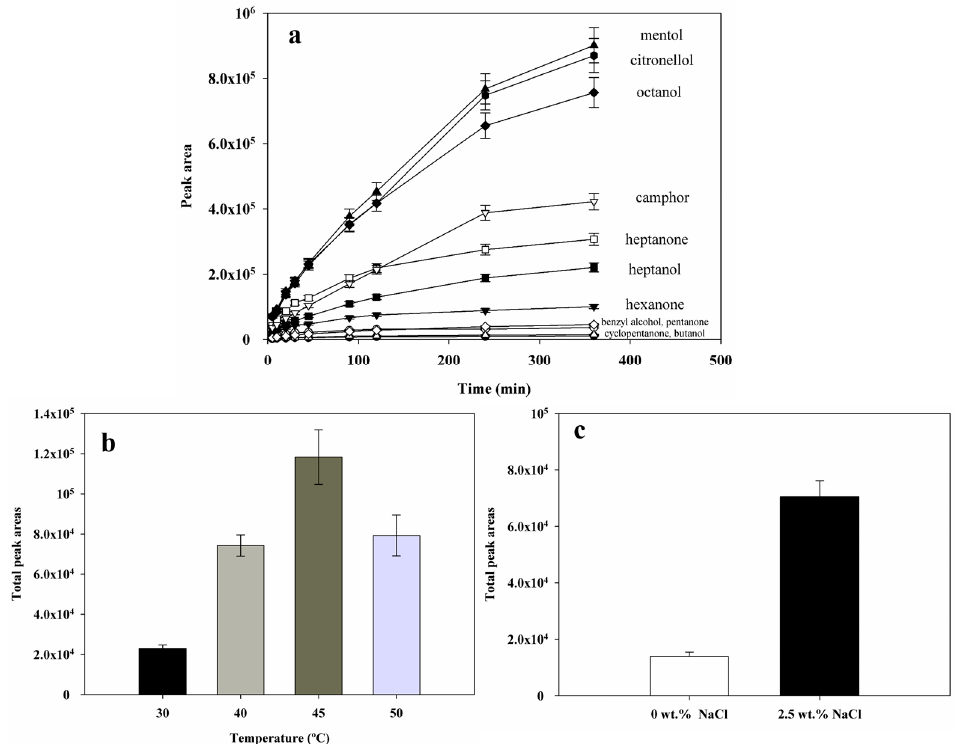
Figure 5. Effects of the different extraction conditions on the efficiency of pD14 towards standard solutions. Extraction time ( a ) ( T = 40 °C, 2.5 wt % of NaCl, 200 rpm, concentration: 50 mg·L − 1 ); extraction temperature ( b ) ( t = 15 min, 2.5 wt % of NaCl, 200 rpm, concentration 20: mg·L − 1 ) and salt concentration ( c ) ( T = 45 °C, t = 15 min, 200 rpm, concentration: 2 mg·L − 1 ).